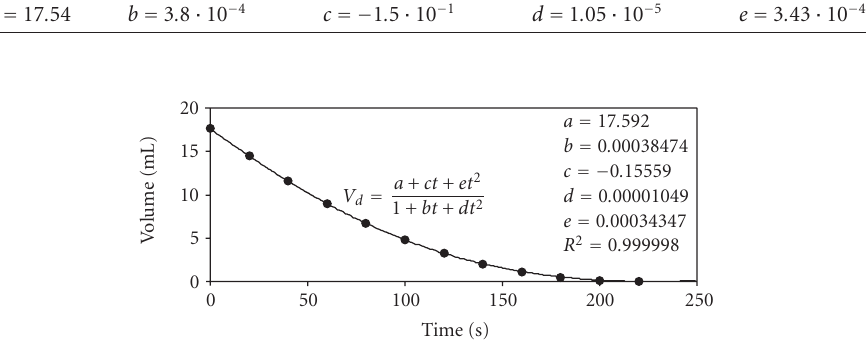
Figure 3.4. Fitting of the drainage data by the function of